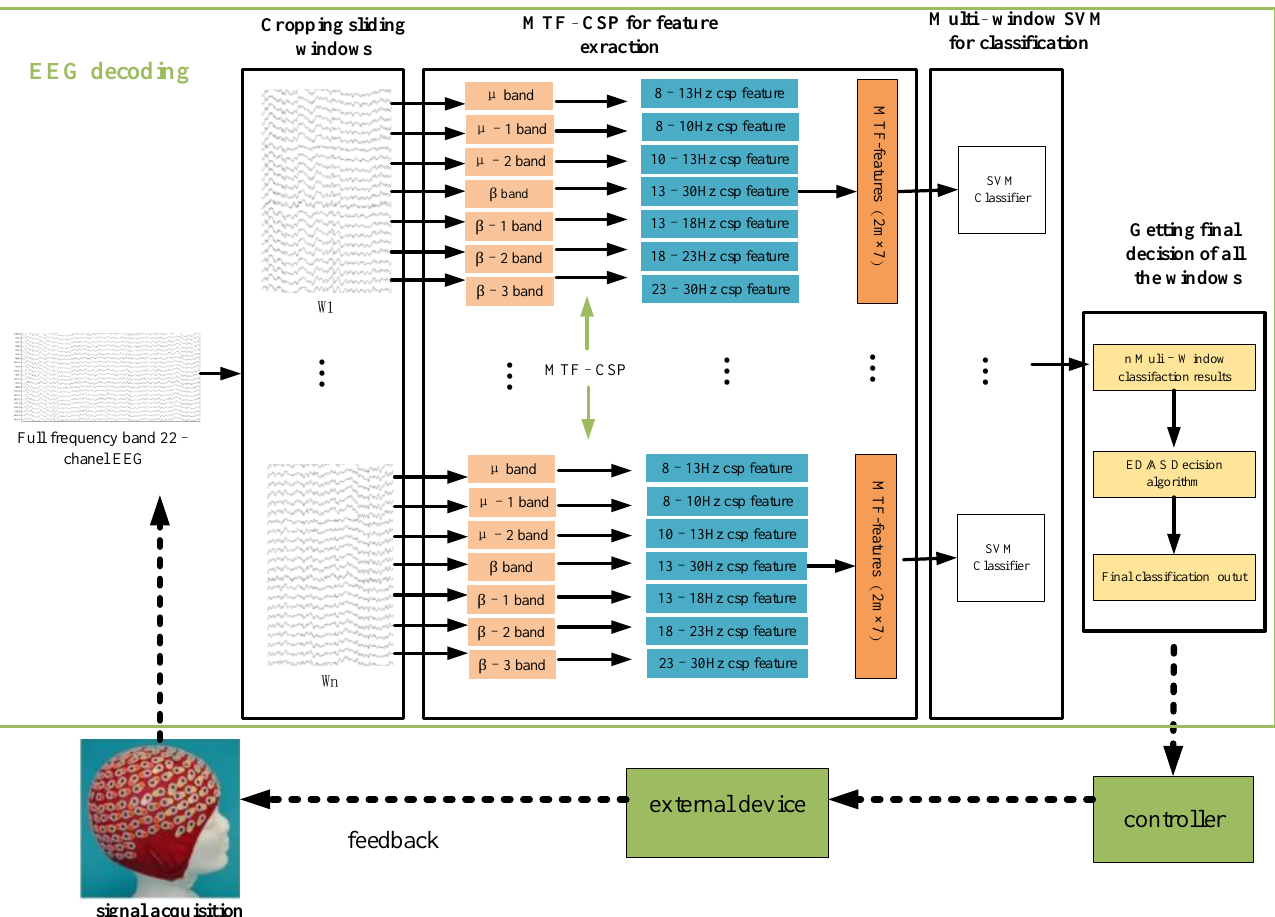
Figure 2. Logic flow diagram of the proposed method.